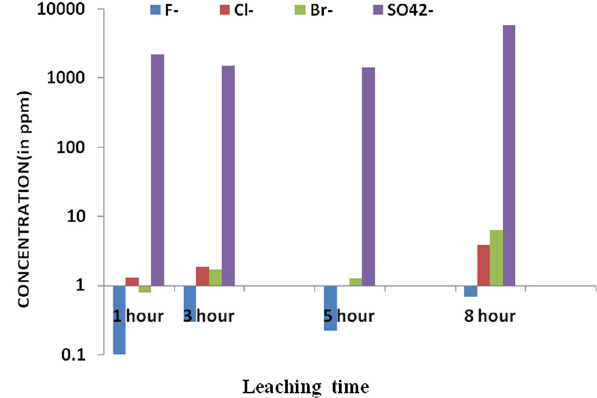
Fig. 16 Change in concentration (in ppm) of anions in aqueous leachates of Ledo coal (LC-60A) with leaching time (in hour) at 45 (cid:3) C